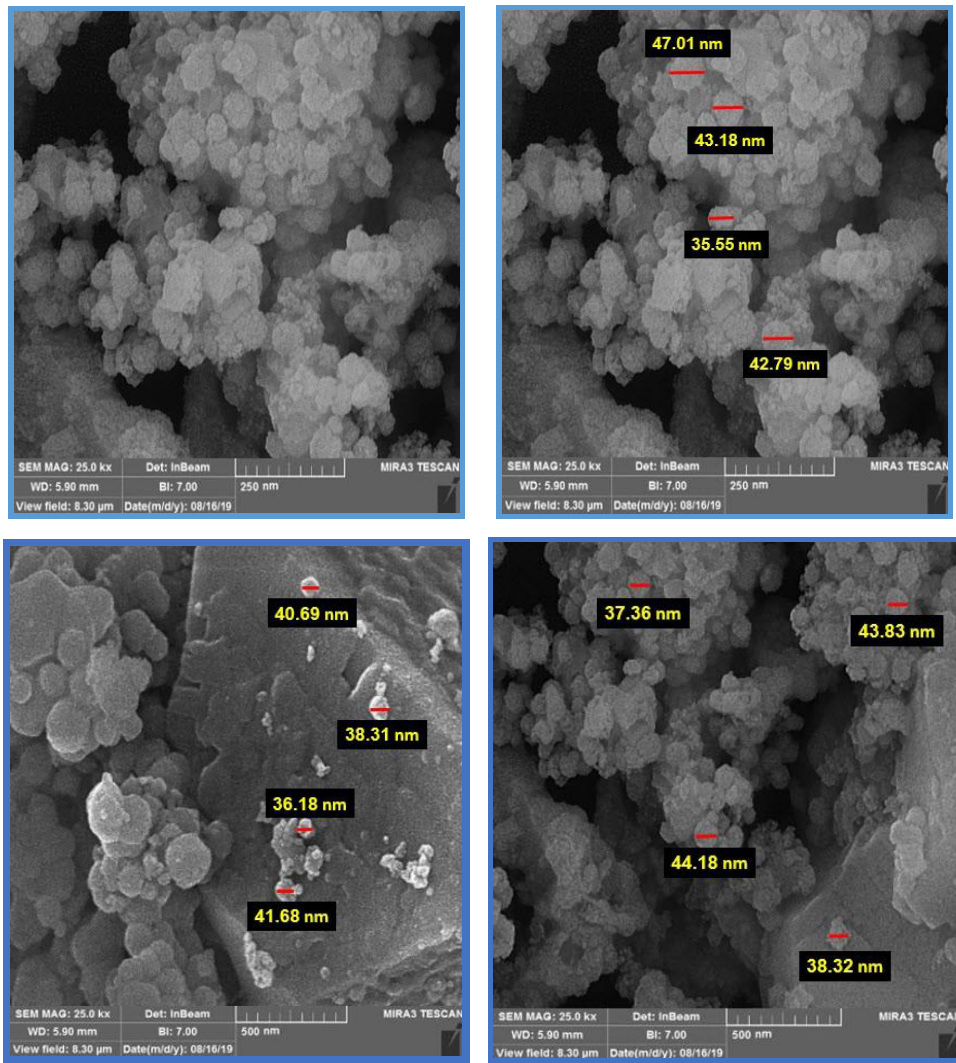
Figure 4. SEM images of the Mn-supported nano-catalyst.